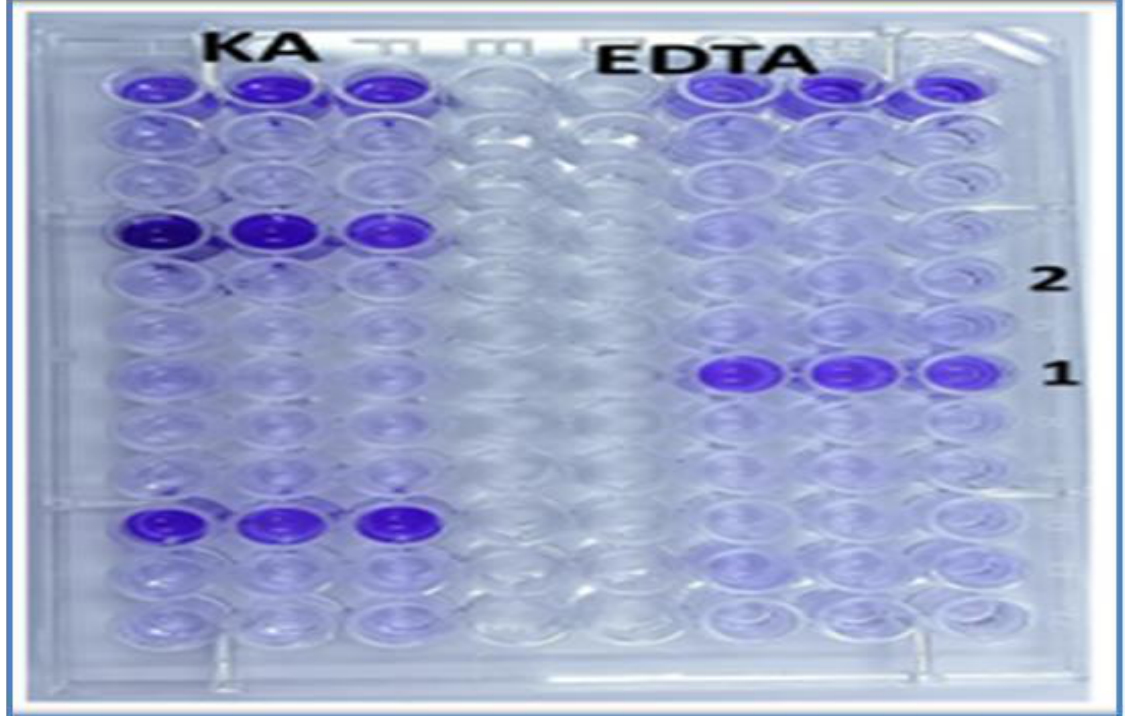
Figure 2. Transformation from strong biofilm former to moderate biofilm former and from biofilm forming to non-biofilm forming isolates under effect of EDTA and Kojic